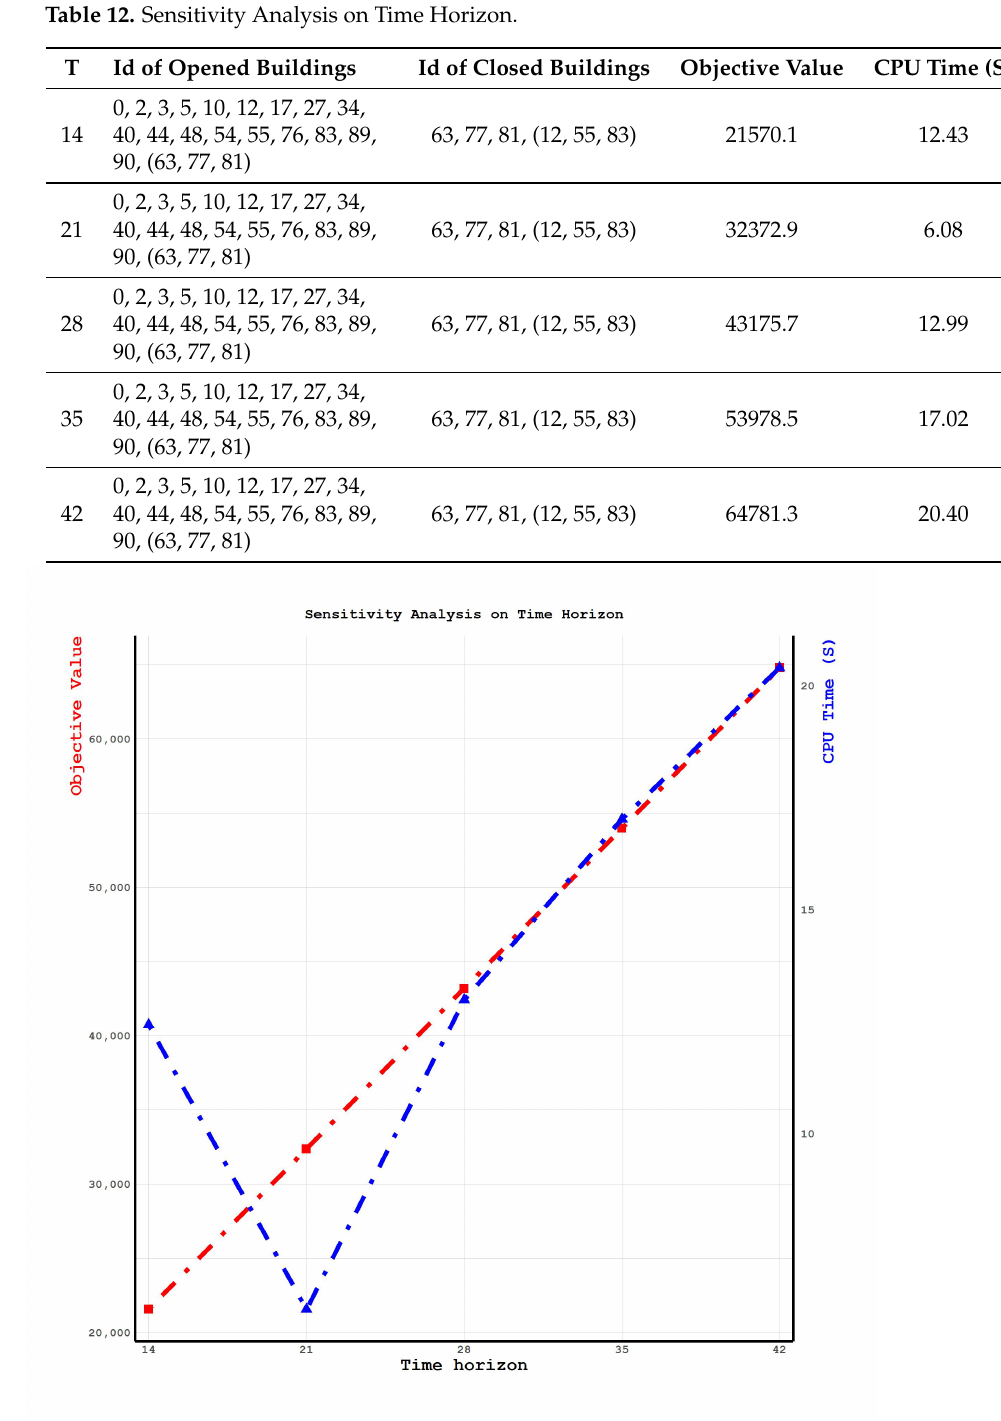
Figure 4. The impact of the time horizon on the objective functions and CPU process